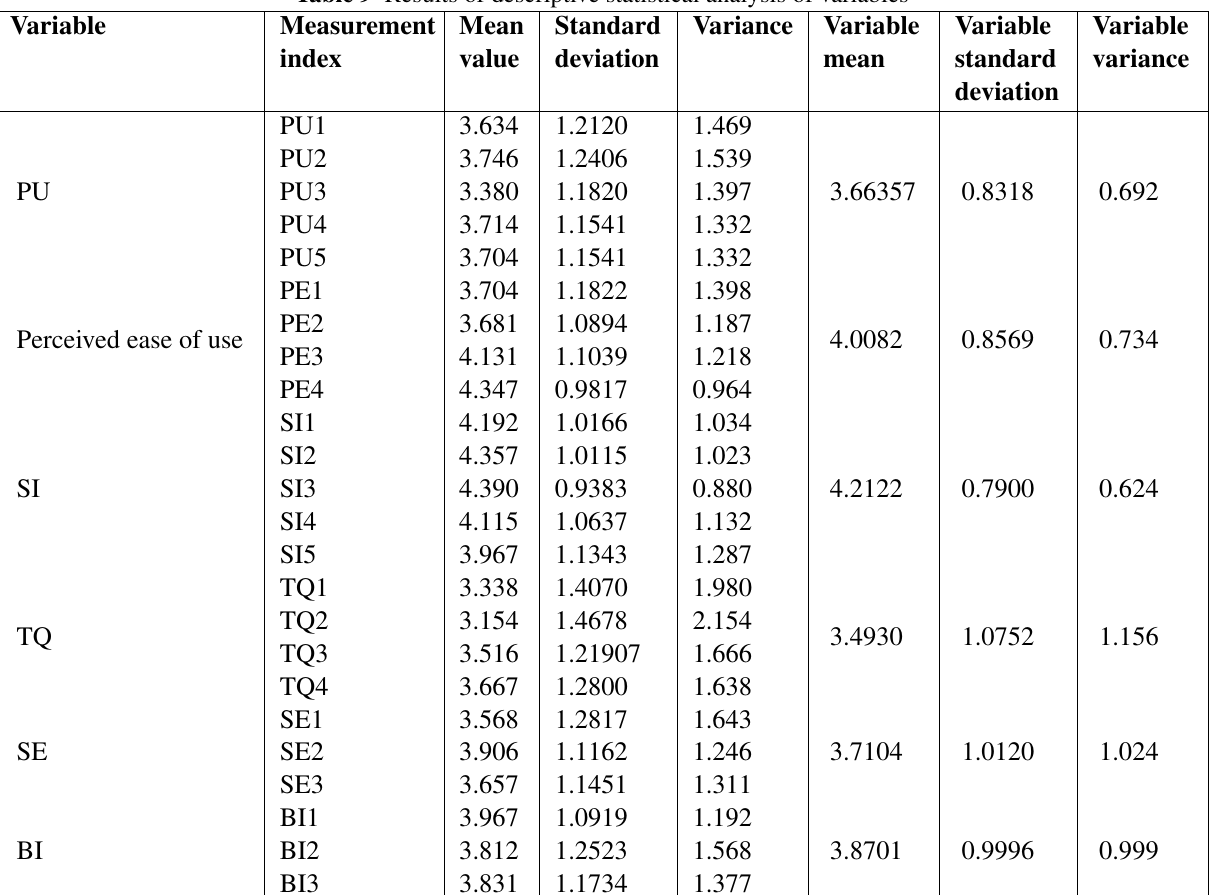
Table 9 Results of descriptive statistical analysis of